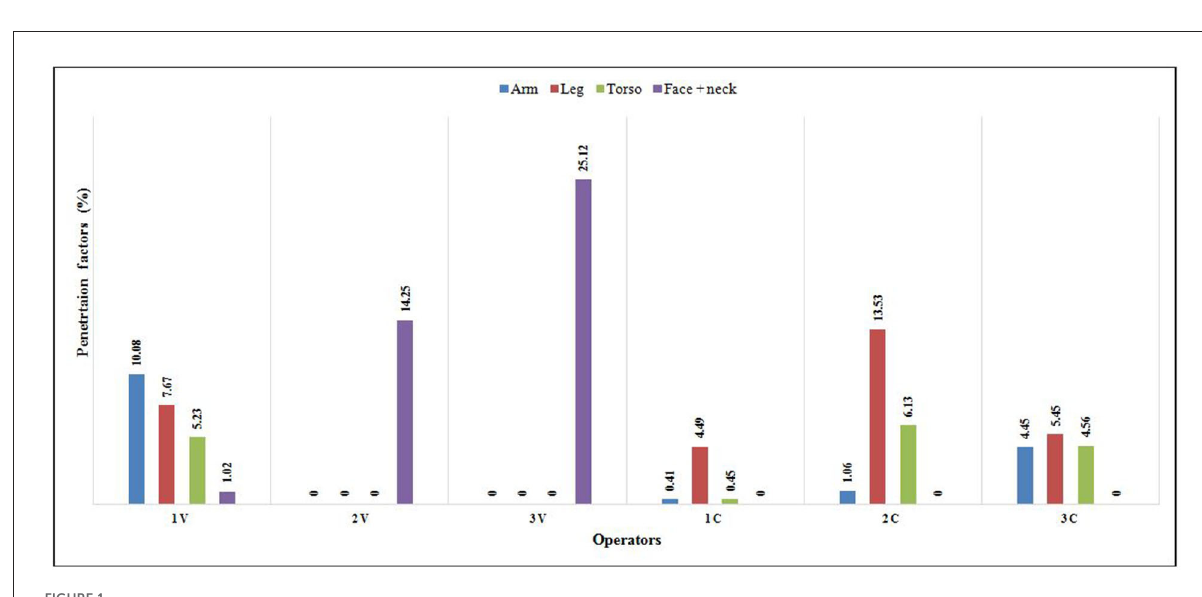
FIGURE1 Penetration factor for each anatomical